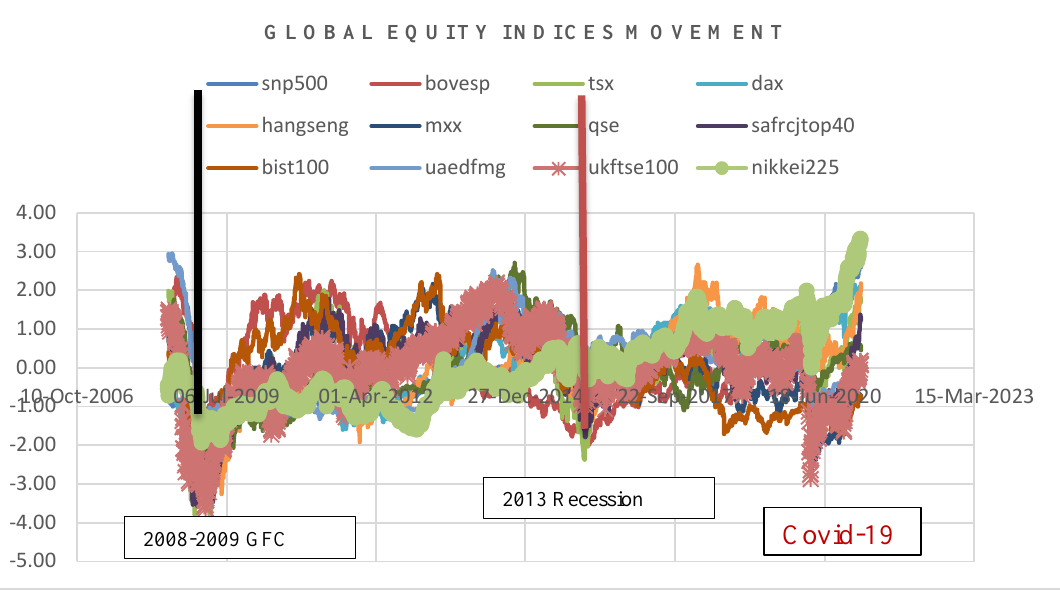
Figure 4: Relationship Among Global Equity Indices; Source: Thompson Reuters, 2021